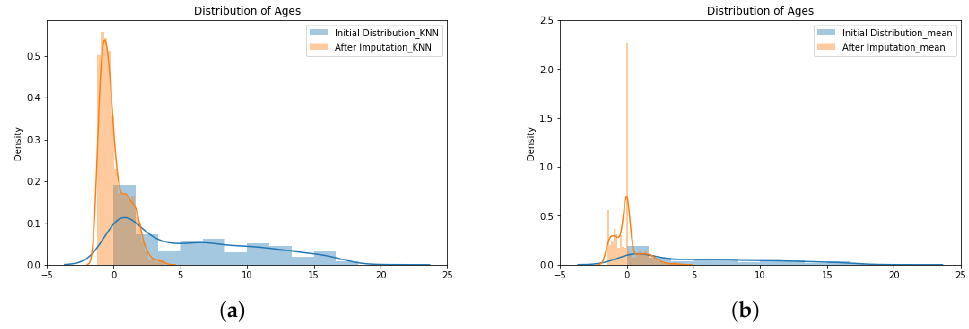
Figure 3. ( a ) Distribution of the age data using the K-nearest neighbor (KNN) imputer; and ( b ) the distribution of age data using simple